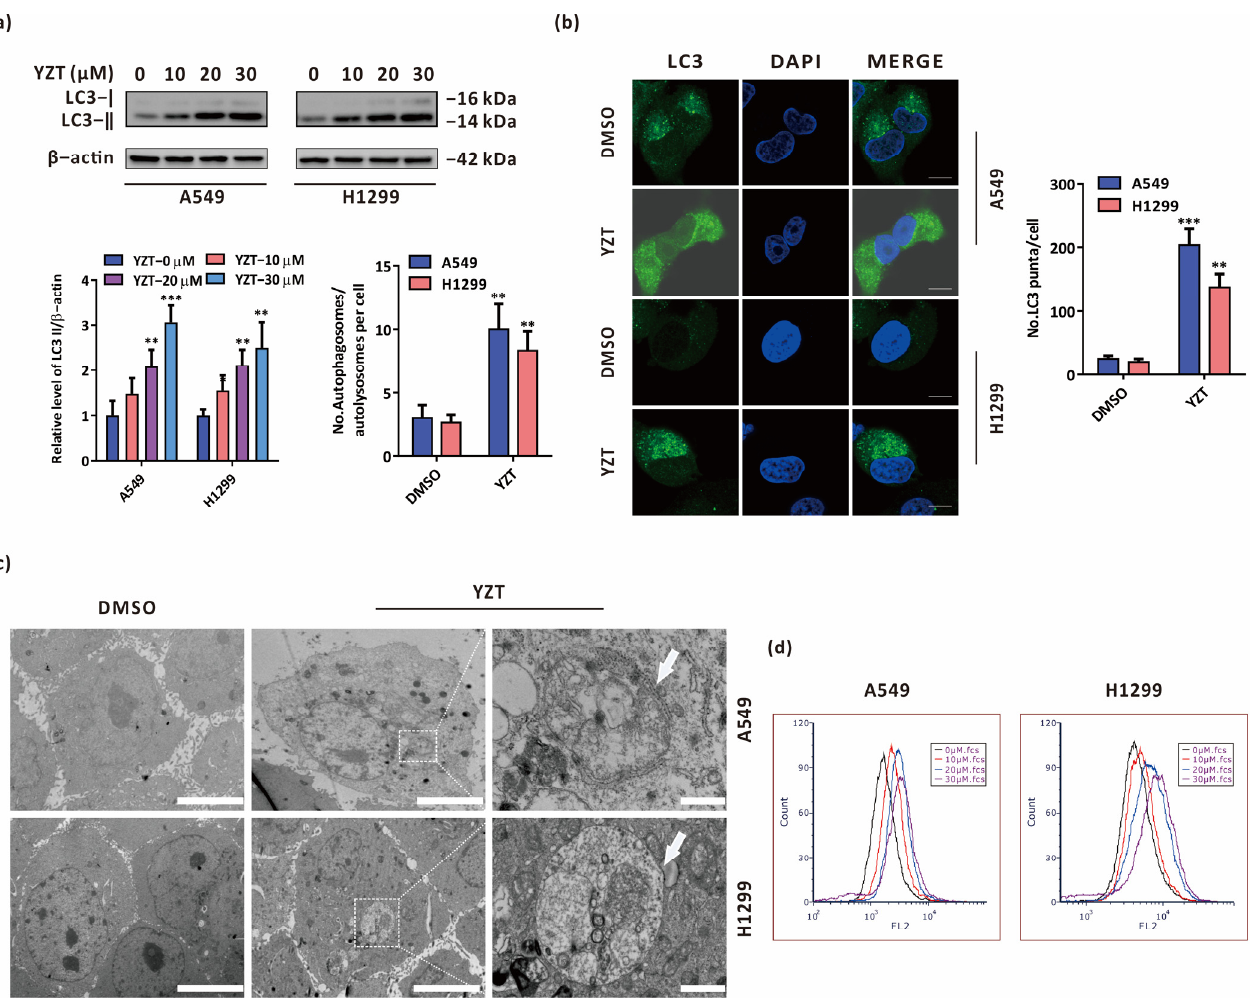
Figure 2. Compound YZT promotes autophagy in NSCLC cells. ( a ) The level of LC3 was determined by immunoblotting. ( b ) Endogenous LC3 puncta were monitored by immunofluorescence. Scale bar: 5 μ m. ( c ) The formation of AVOs was detected by AO staining. ( d ) The ultrastructural morphology of autophagosomes/autolysosomes was visually observed under TEM. Scale bars: left and middle, 5 µ m; right, 1 µ m. Significant differences were designated as ** p < 0.01 and *** p < 0.001.